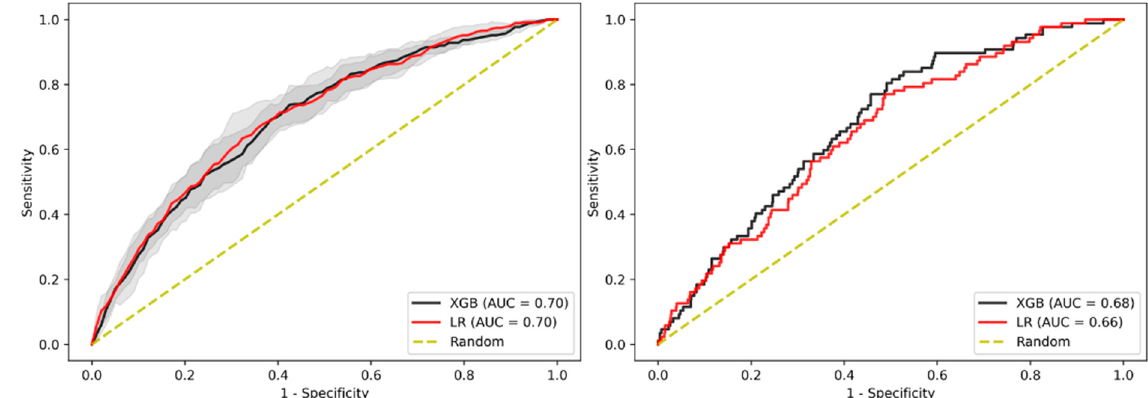
Figure 6. AUC-ROC performance of the XGBoost-based model and LR-based model to identify patients with AA when removing patients with adenomas. Internal validation cohort ( left ) and test cohort ( right ). Confidence intervals of 95% are shown in shaded grey.